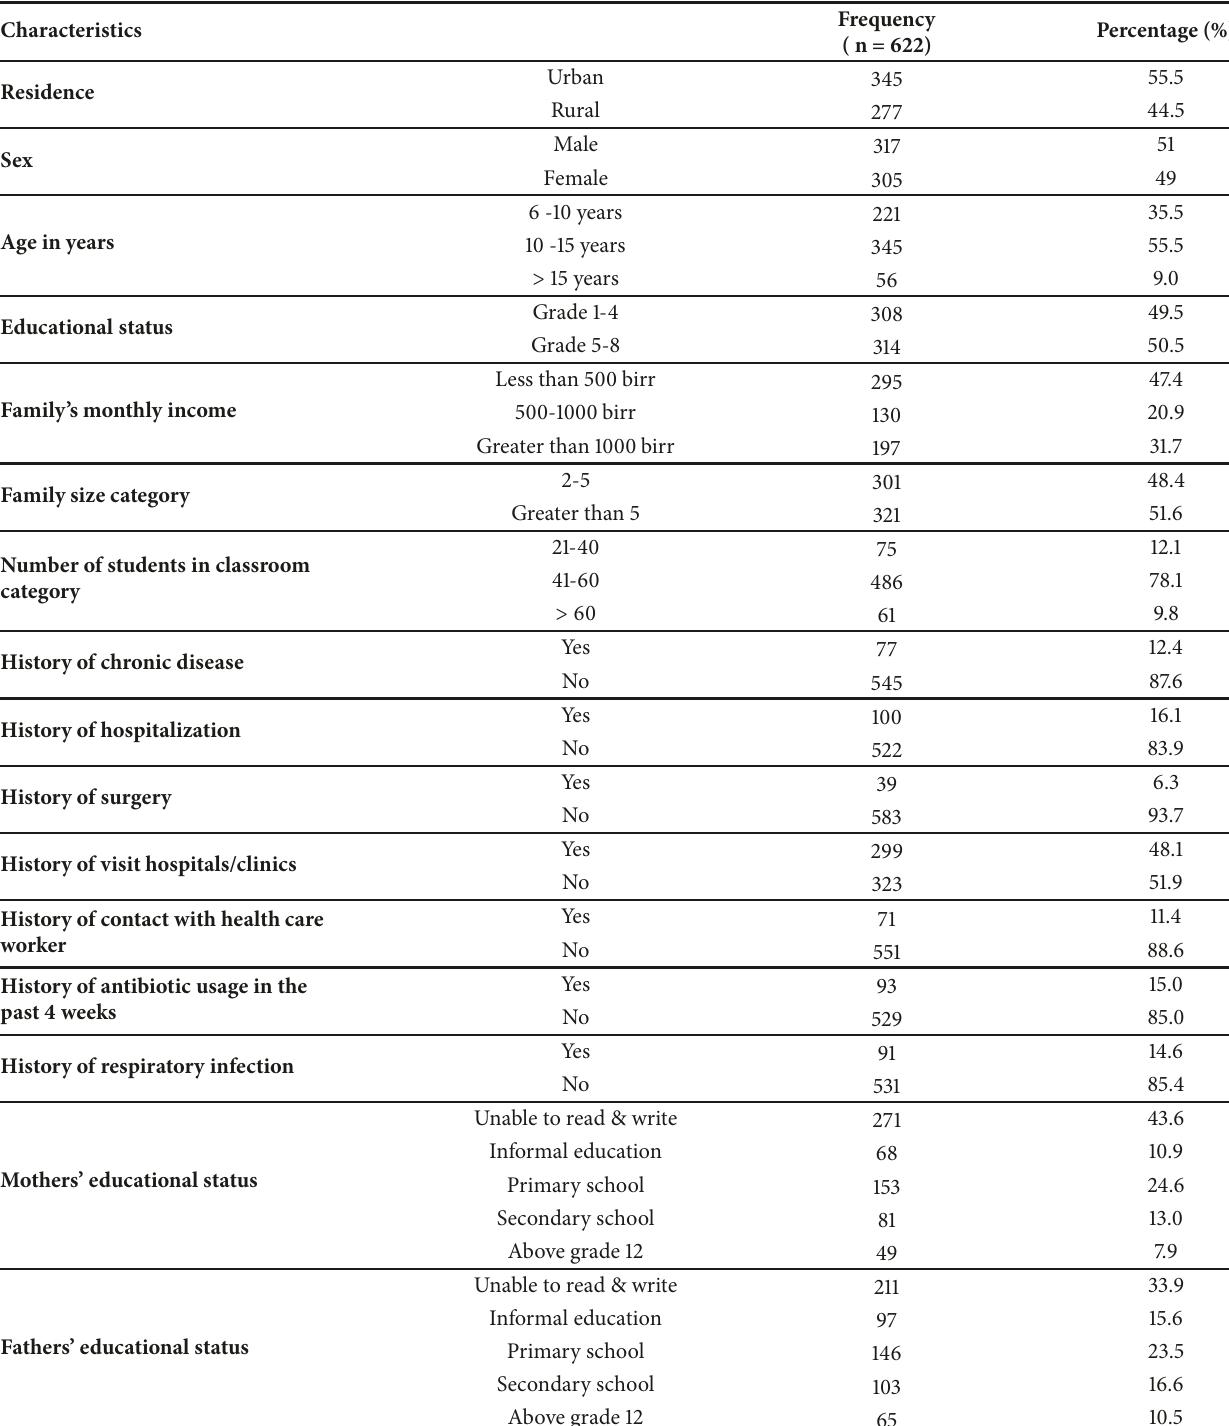
Table 1: Sociodemographic characteristics of study participants among elementary school children in Gondar, Northwest Ethiopia, 2018.